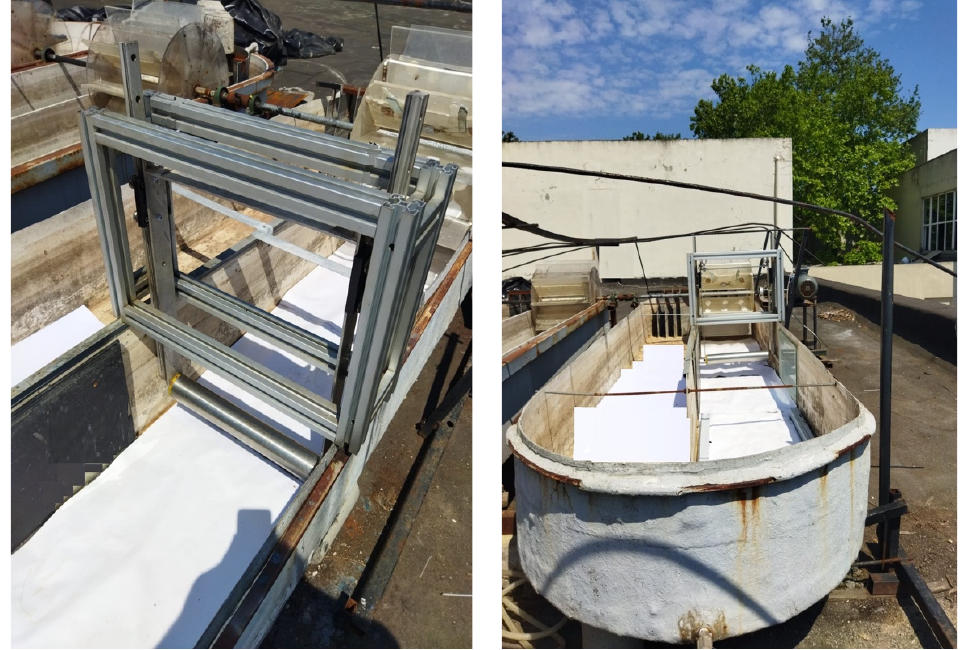
Figure 5. A view of experimental RWP with VIV system: General view of RWP with VIV system ( right ), Detailed view of VIV system ( left ).